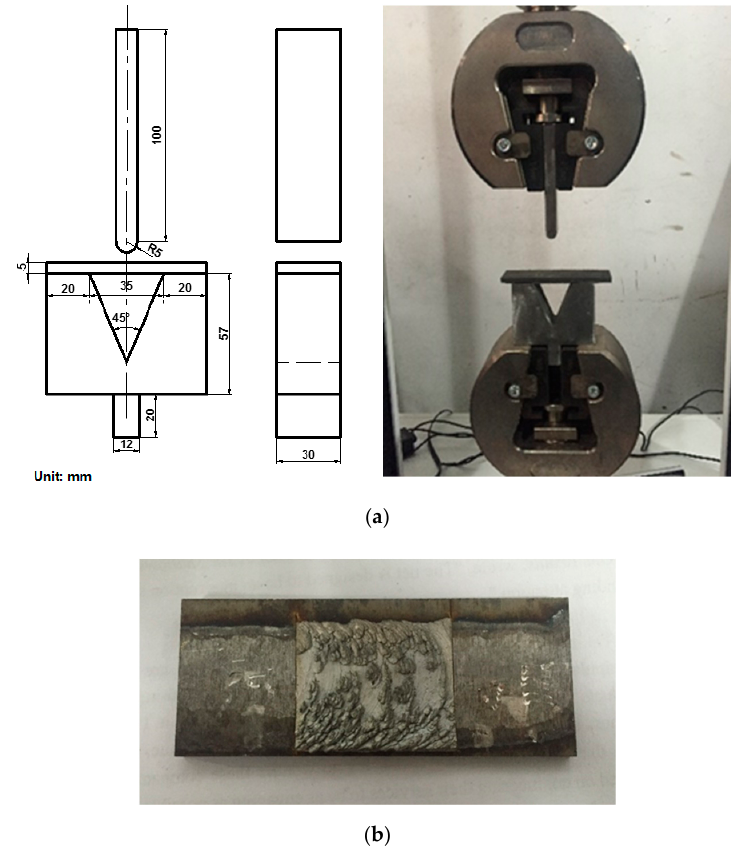
Figure 5. Bending test: ( a ) test setup; ( b ) bending specimen.